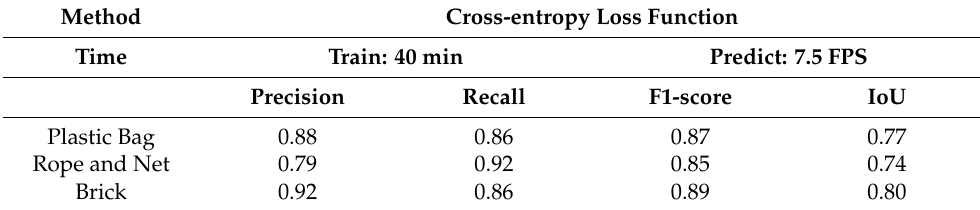
Table 4. Training with cross-entropy loss